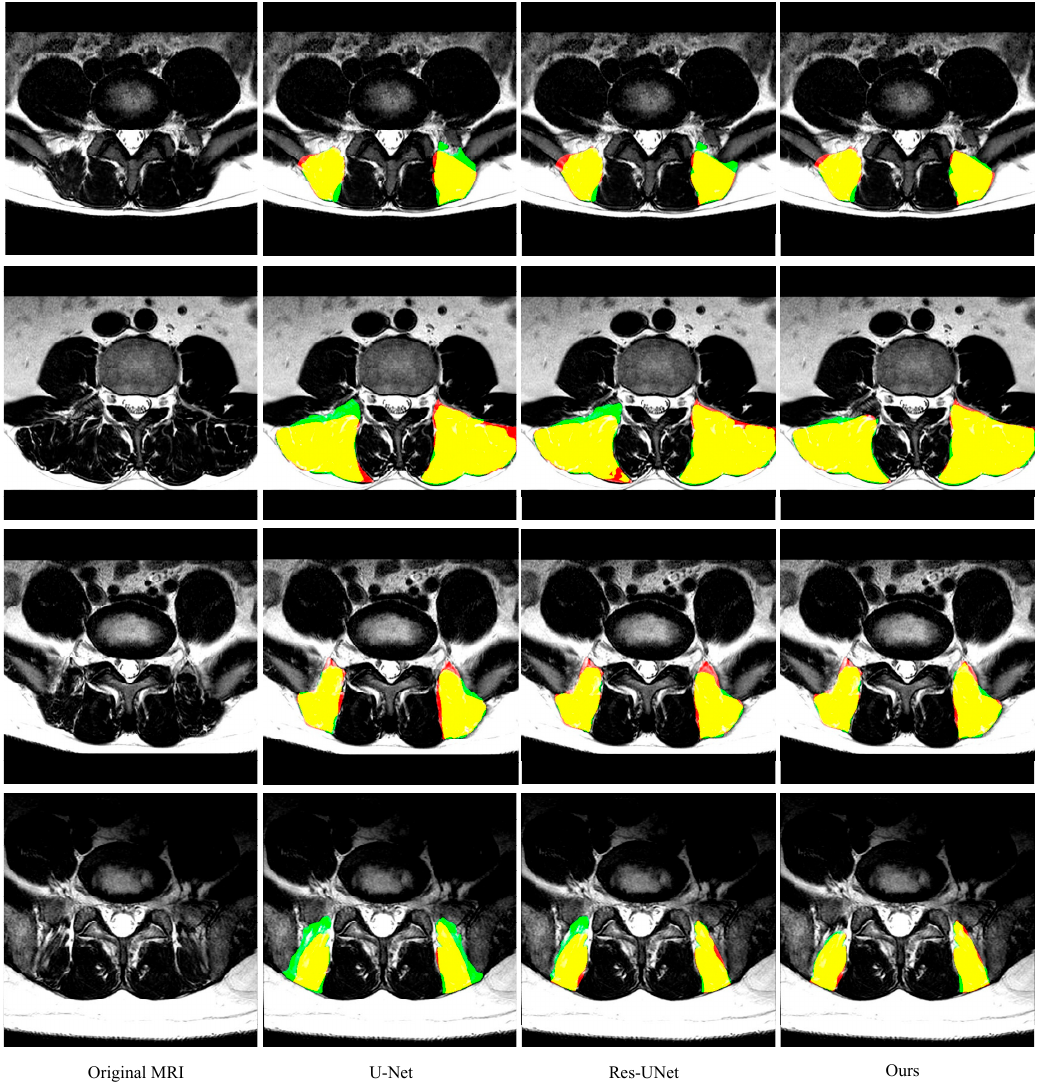
Figure 7. Representative cases of the segmentation results of the ES obtained by U-Net, ResU-Net, and our segmentation network. Table 2. The performance of various models on the ES test set (the best results are indicated in bold).